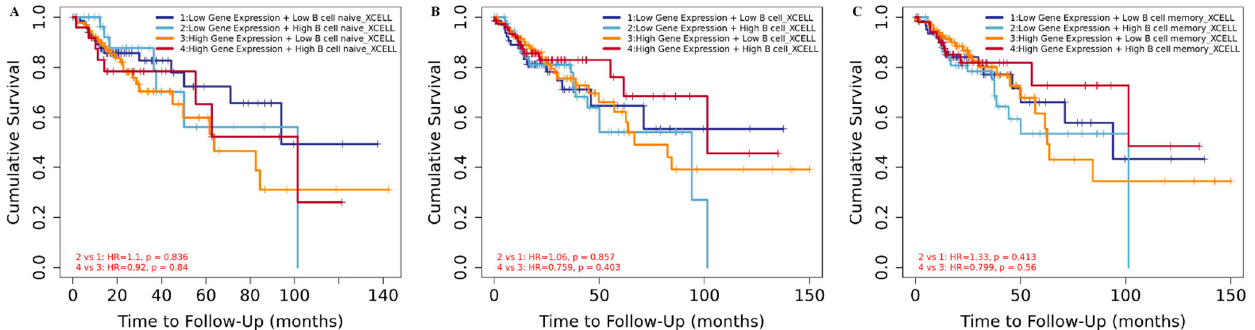
Figure 3. Clinical outcome of HDAC2 -related COAD based on B-cell infiltrates. ( A ) Kaplan–Meier curve for naïve B cells in HDAC2 -related COAD patients; score (log-rank) test p = 3.15 × 10 − 5 ( B ) Kaplan–Meier curve for B cells in HDAC2 -related COAD patients; score (log-rank) test p = 8.86 × 10 − 3 ; ( C ) Kaplan–Meier curve for memory B cells in HDAC2 -related COAD patients; score (log-rank) test p = 9.65 × 10 − 3 .